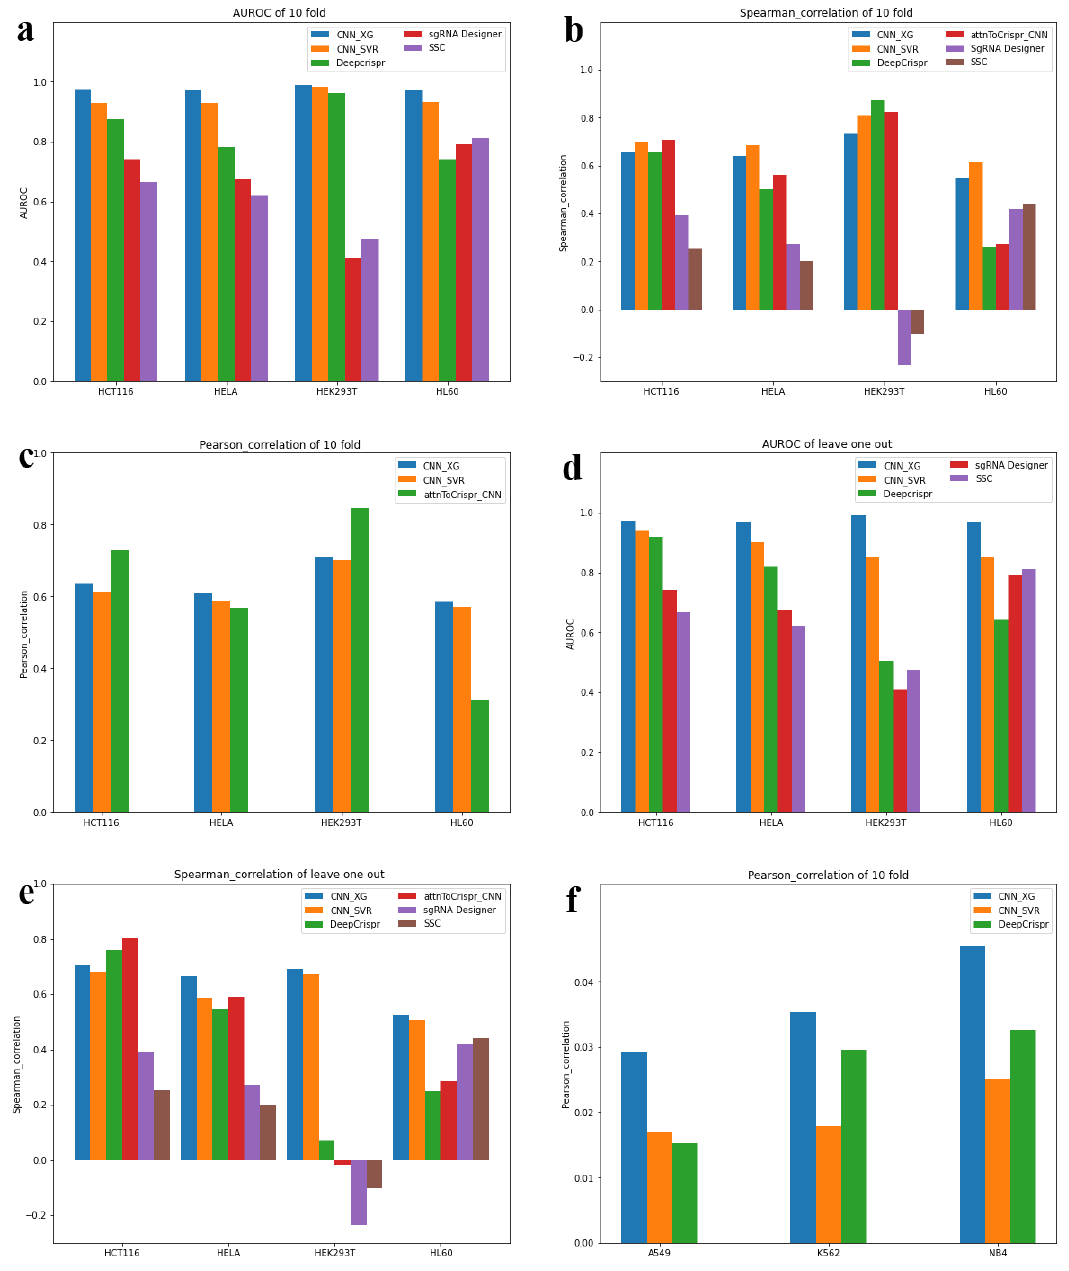
Figure 3. Evaluation of CNN-XG for on-target profile prediction. ( a – c ) Comparison of sgRNA on- target efficacy predictions for HCT116, HELA, HEK293T and HCT116 in 10-fold cross-validation in classification mode and regression mode. ( d , e ) Comparison of sgRNA on-target efficacy predictions in regression and classification schema for various datasets, i.e., HCT116 cell line, HELA cell line, HEK293T cell line, HCT116 cell line. ( f ) The result of a generalization ability test in new cell